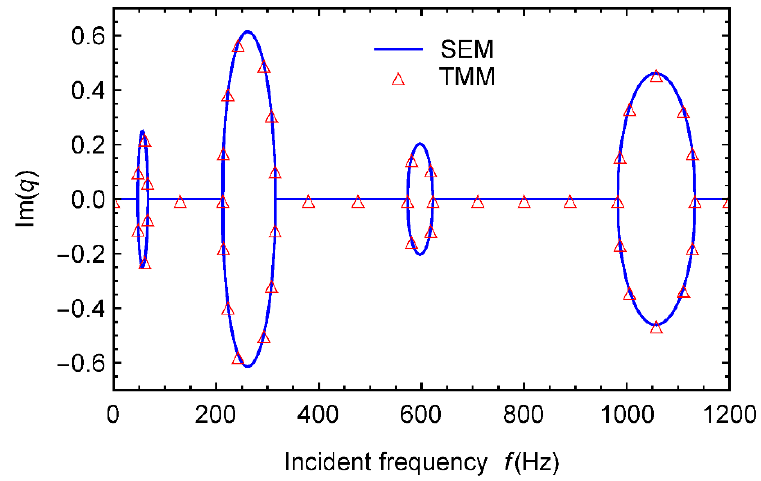
Figure 3. Imaginary part of the present fluid-conveying pipe with periodically varying cross-section.